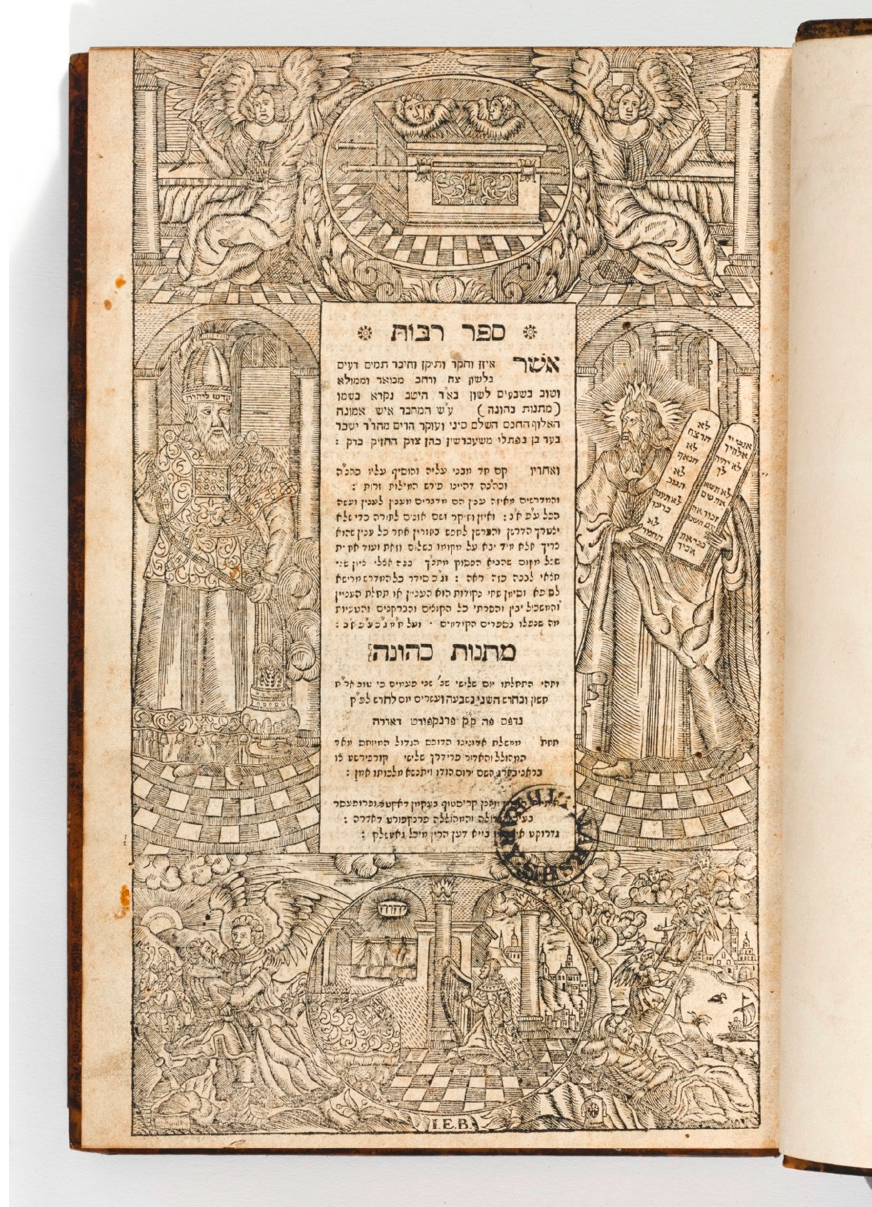
Figure 7. Sefer Rabot (Midrash Rabbah); Marsh’s Library C.3.1.11.